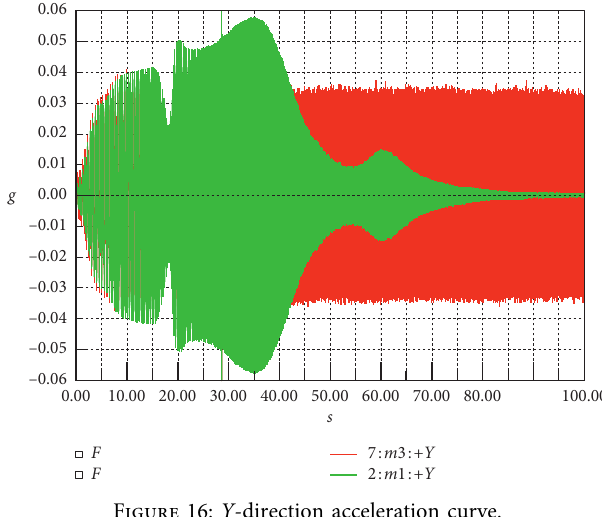
Figure 19: Y -direction vibration isolation system transmission rate.